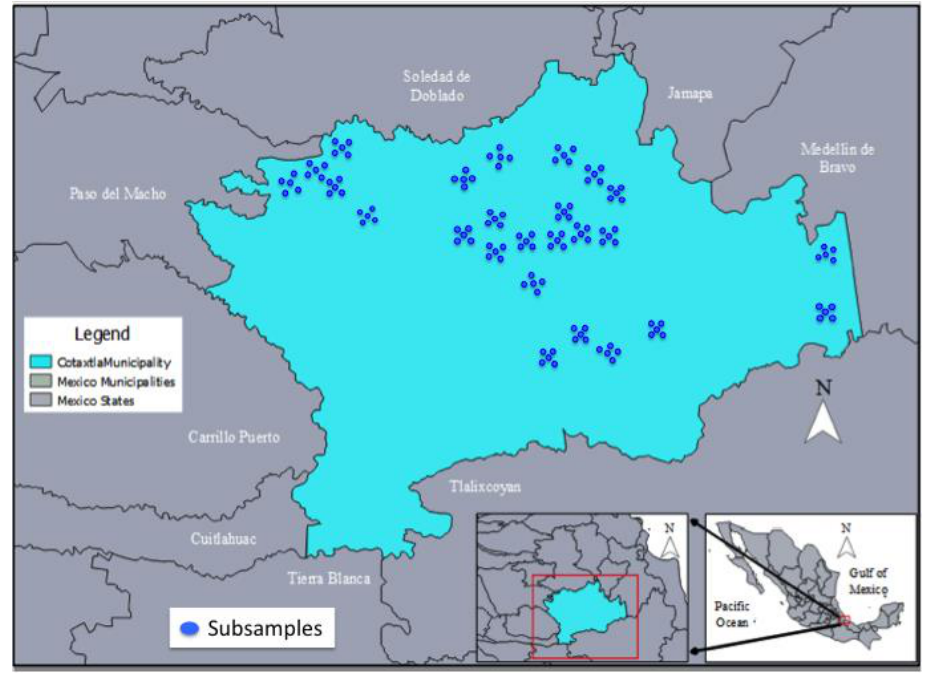
Figure 1. Location of the study area and sampling points in the municipality of Cotaxtla.